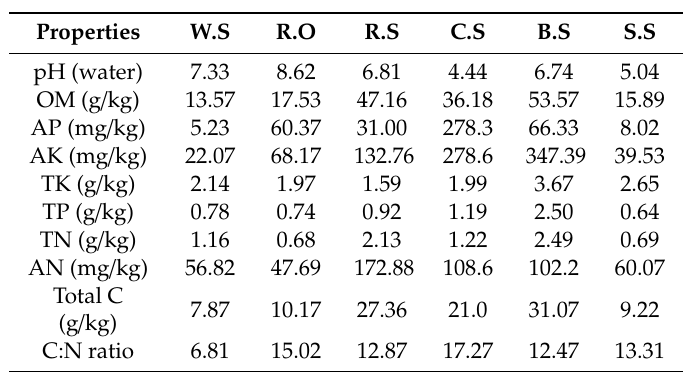
Table 1. Properties of the di ff erent